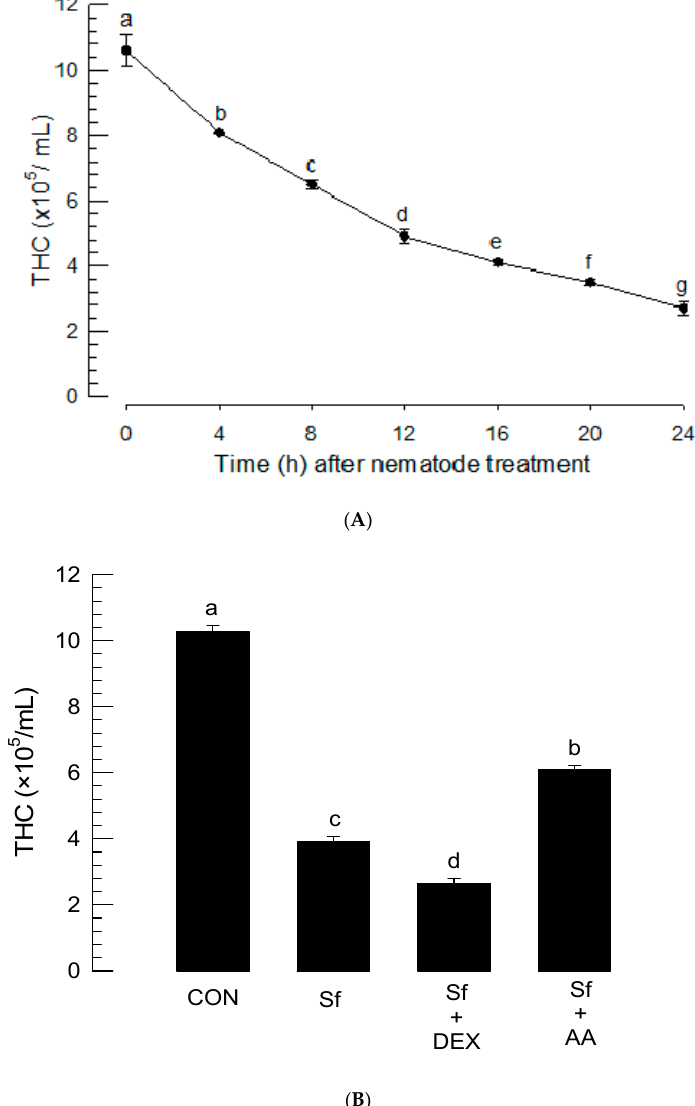
Figure 6. Suppression of total hemocyte counts (THC) of P. xylostella larvae infected with S. feltiae K1. ( A ) Temporal change of THC after the nematode infection. Fourth instar larvae of P. xylostella were treated with 80 IJs per larva. ( B ) Rescue e ff ect of arachidonic acid (‘AA’, 10 µ g / larva) or dexamethasone (‘DEX’, 10 µ g / larva) addition on THC. Test chemicals were injected just before nematode (‘Sf’) treatment (80 IJs / larva). THC was assessed at 16 h after the nematode treatment. Each treatment was replicated three times. Di ff erent letters above standard error bars indicate significant di ff erence among means at Type I error = 0.05 (LSD